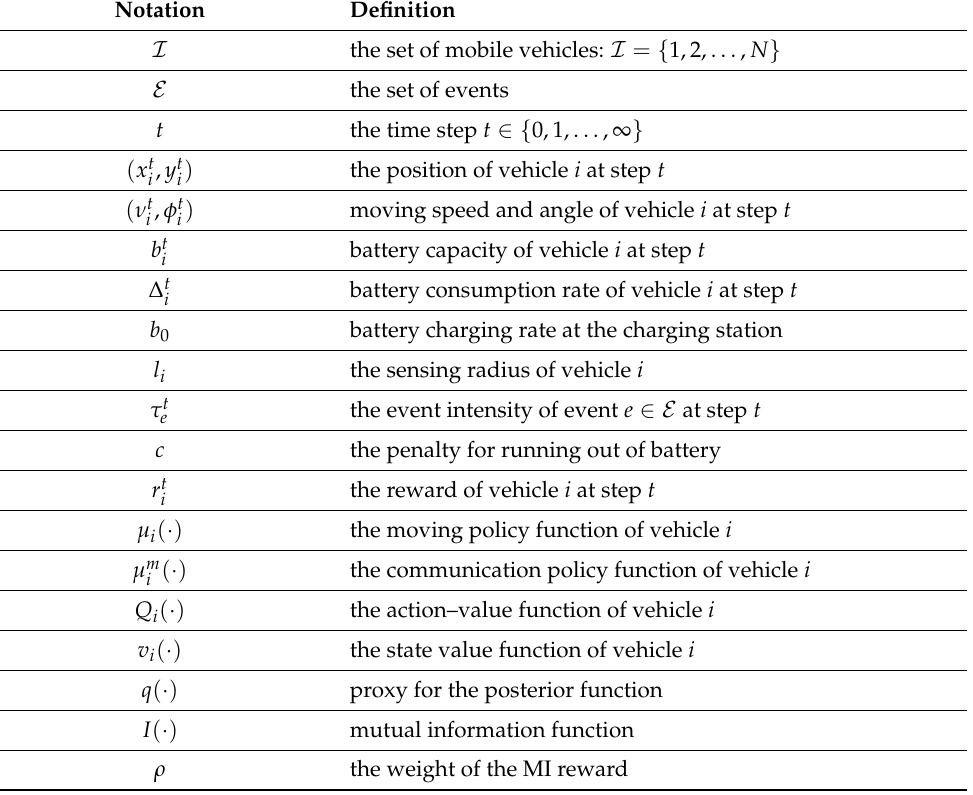
Table 1. Key parameter table of system